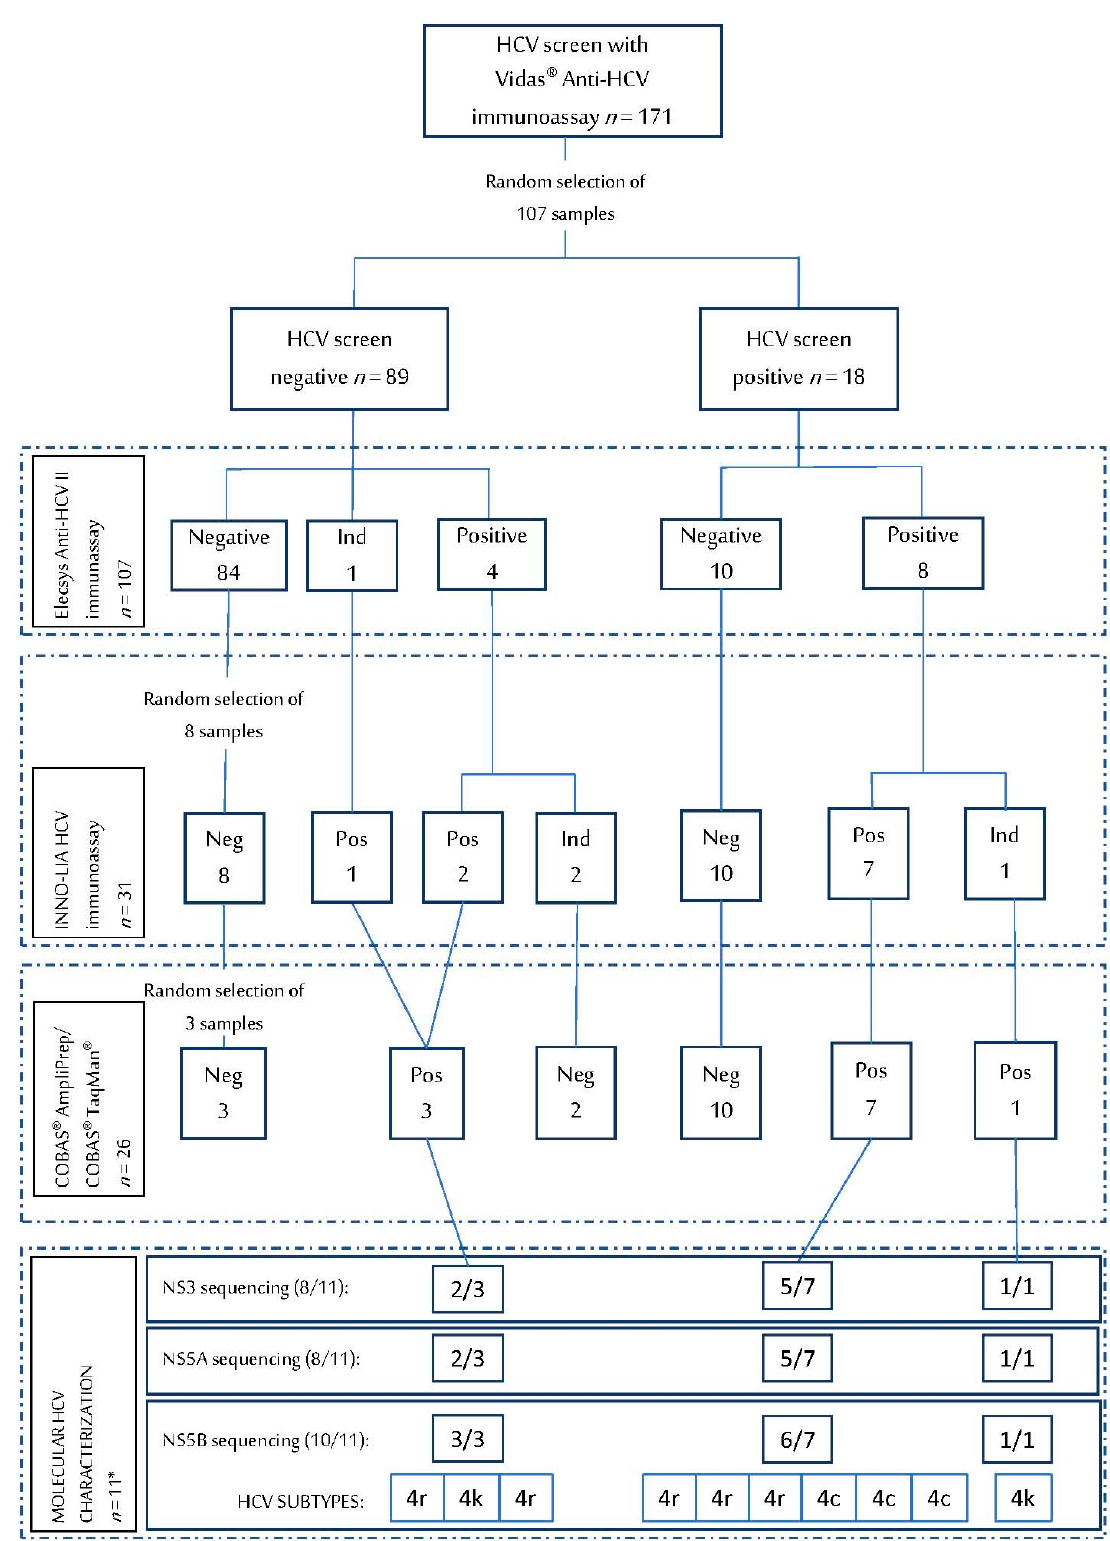
Figure 1. Summary of results obtained with serological and molecular techniques using dried blood spots (DBS) collected in Kinshasa (DRC). * Note: Resistance testing was attempted on all samples from viraemic patients ( n = 11). Three samples with HCV viral load below 1000 IU/mL could not be amplified for NS3 and NS5A, but two of them could be subtyped by NS5B sequencing.